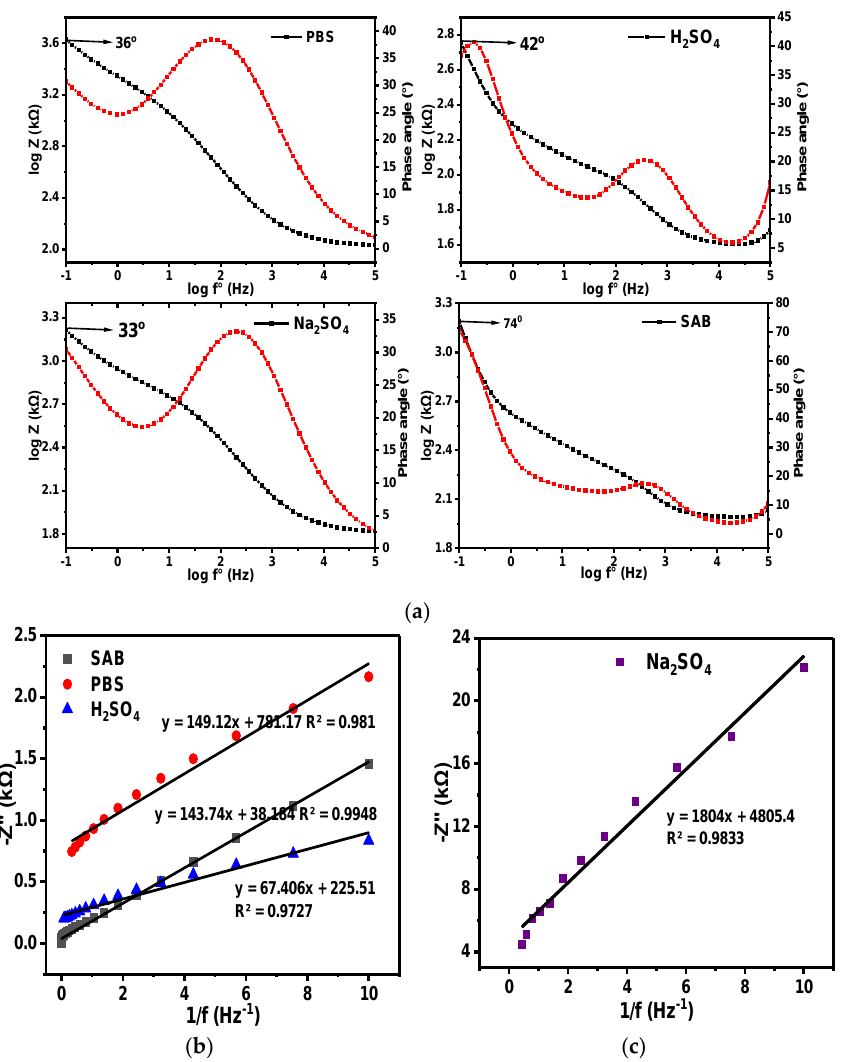
Figure 15. ( a ) Bode plots of − phase angle (°) vs. log f° and plots of log Z vs. log f° for GCE- NiPcMWCNTs in PBS, H 2 SO 4 , Na 2 SO 4 , and SAB electrolytes. ( b ) and ( c ) are the corresponding plots of −Z″ vs . 1/ f°.